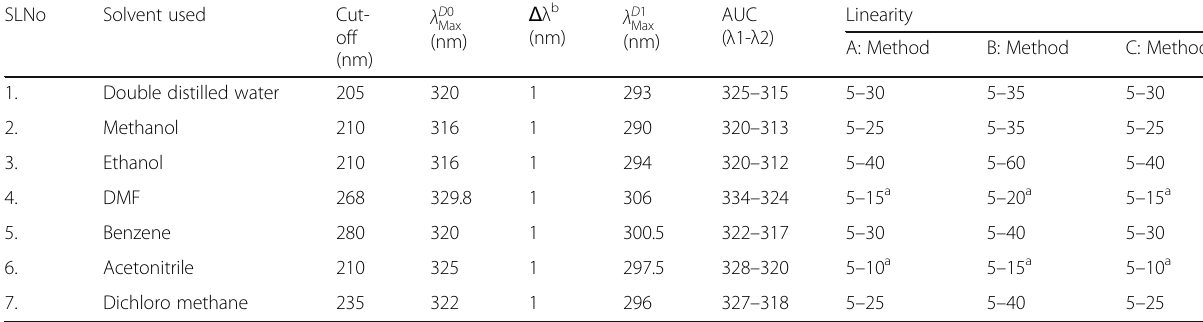
Table 1 Report of UV-spectroscopic characteristics for satranidazole (STZ) in various solvents